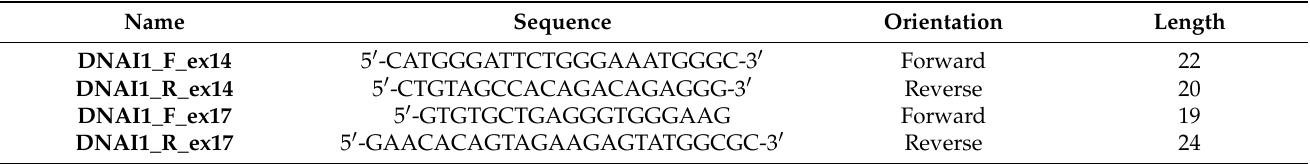
Table 1. List of primers used for sequencing